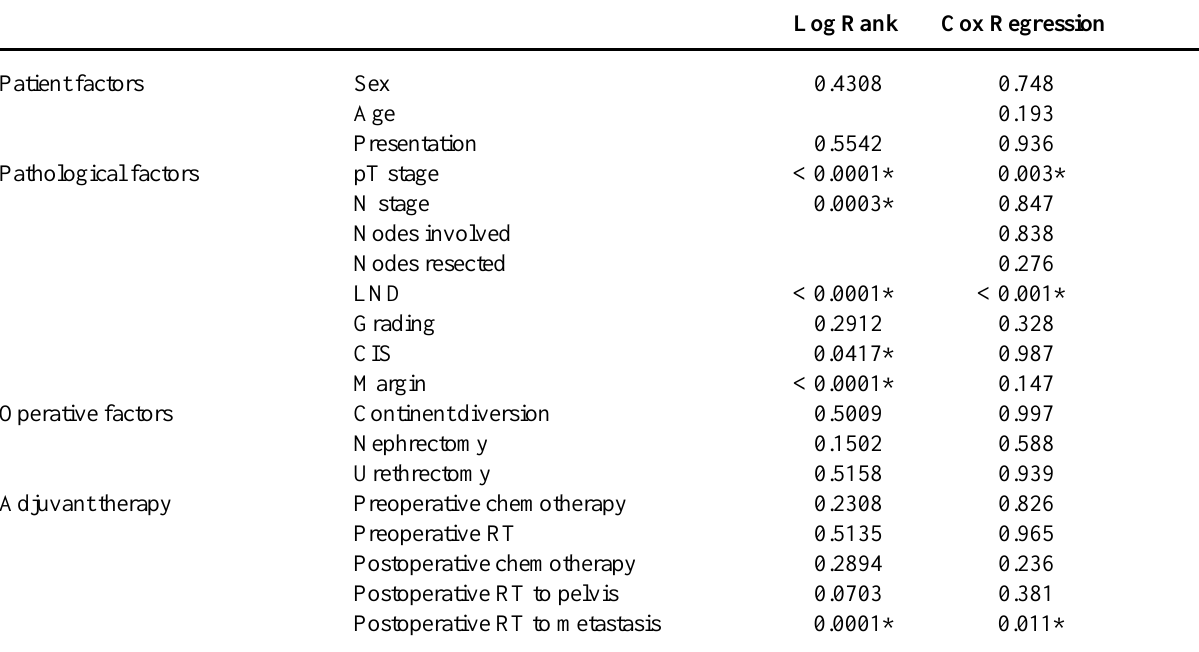
Table 3 – Summary of univariate and multivariate analyses of effects of various prognostic factors on disease specific